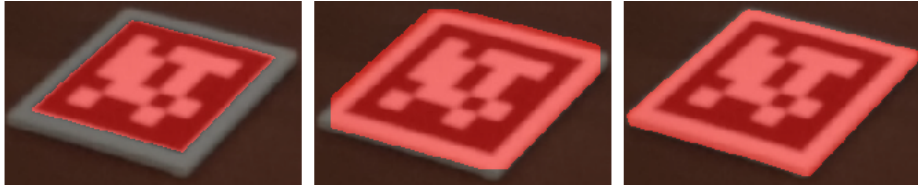
Figure 7. Methods for mask creation: ( left ) detection; ( center ) 2D dilation; ( right ) 3D projection.